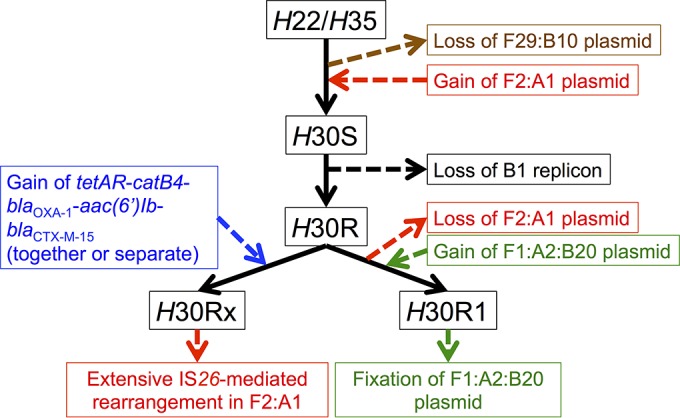
Proposed events leading to currently circulating plasmids in ST131-H30R1 and H30Rx.